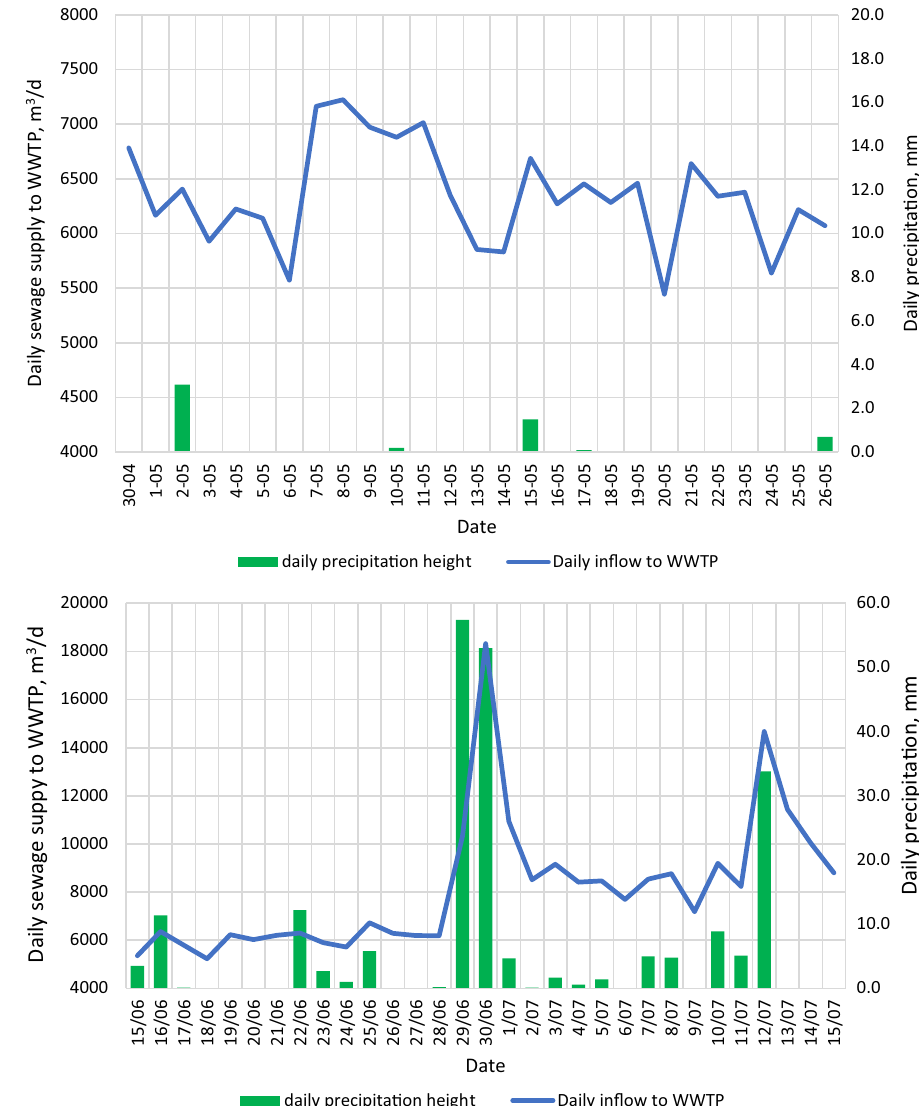
daily precipita(cid:8)on height Daily inflow to